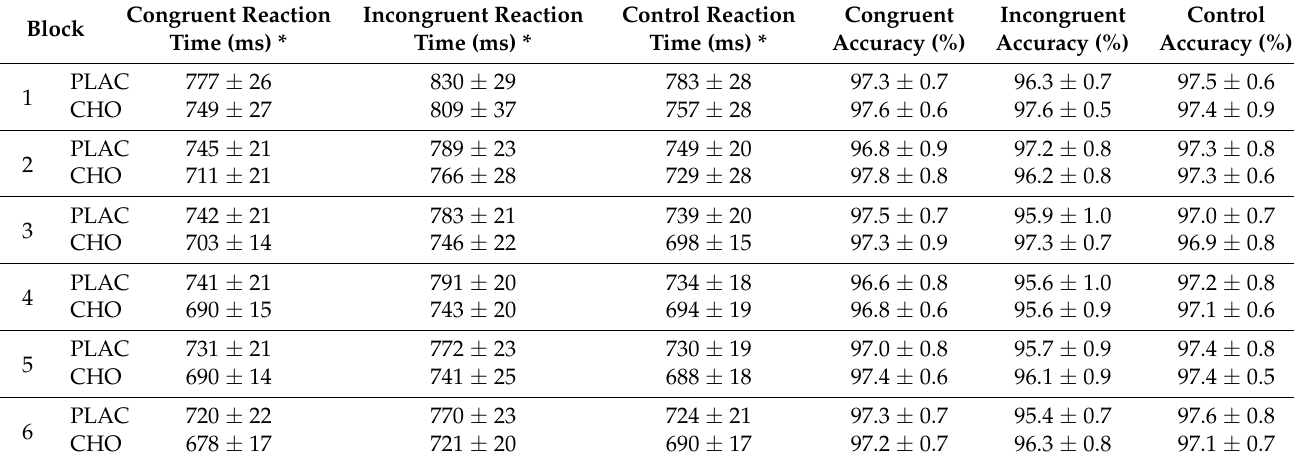
Table 1. SWCT performance over repeated application when using placebo (PLAC) or carbohydrate (CHO) mouth rinse. Block